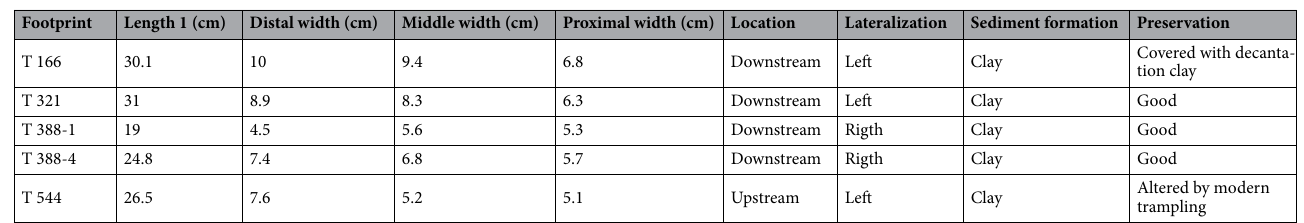
Table 1. Characteristic of the Cussac Cave footprints